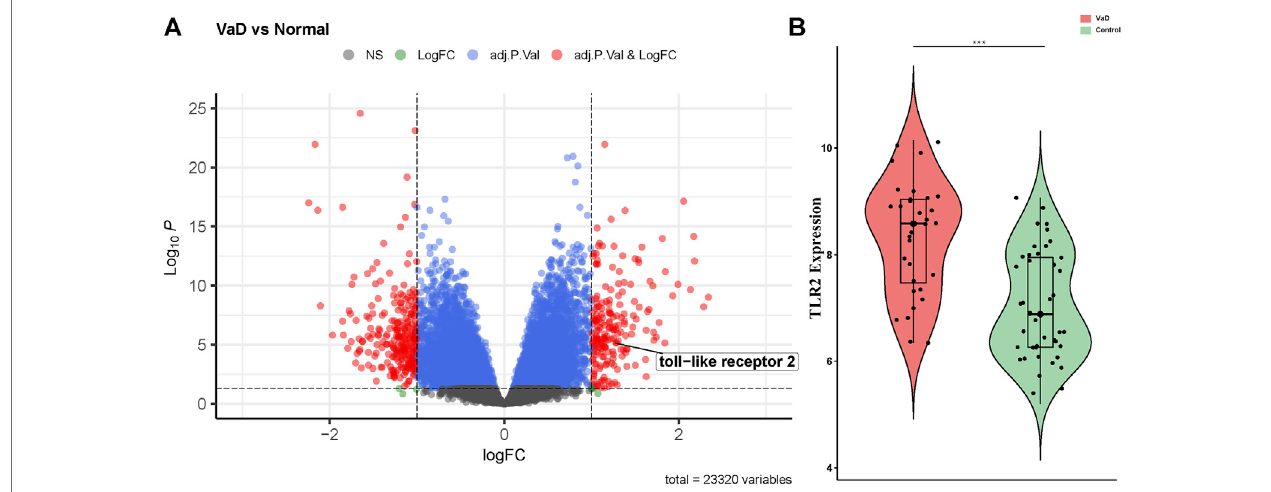
FIGURE3| Differentiallyexpressedgenes(DEGs)presentinvasculardementia(VaD)andcontrolgroupsinmicroarrayfromGSE122063andtheexpressionlevelof Toll-like receptor-2 (TLR2). (A) Volcano plot showed the distribution ofthe DEGs between twogroups. The red dots correspond to the signi fi cantly regulated genes. (B) Violin plot of TLR2. TLR2 is upregulated in the VaD group (*** p < 0.001).